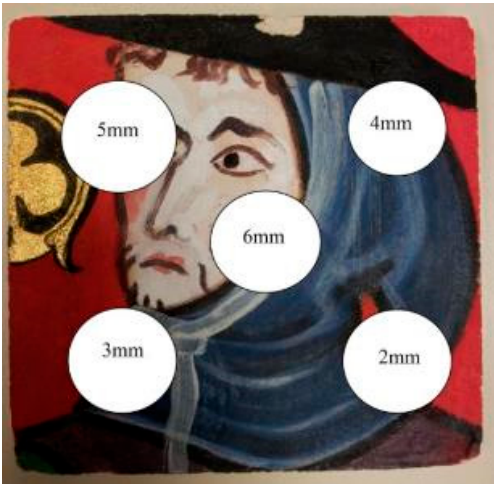
Figure 11. The copy of the mural painting “Saint Maurille en Ev è que” studied: Positioning of defects.